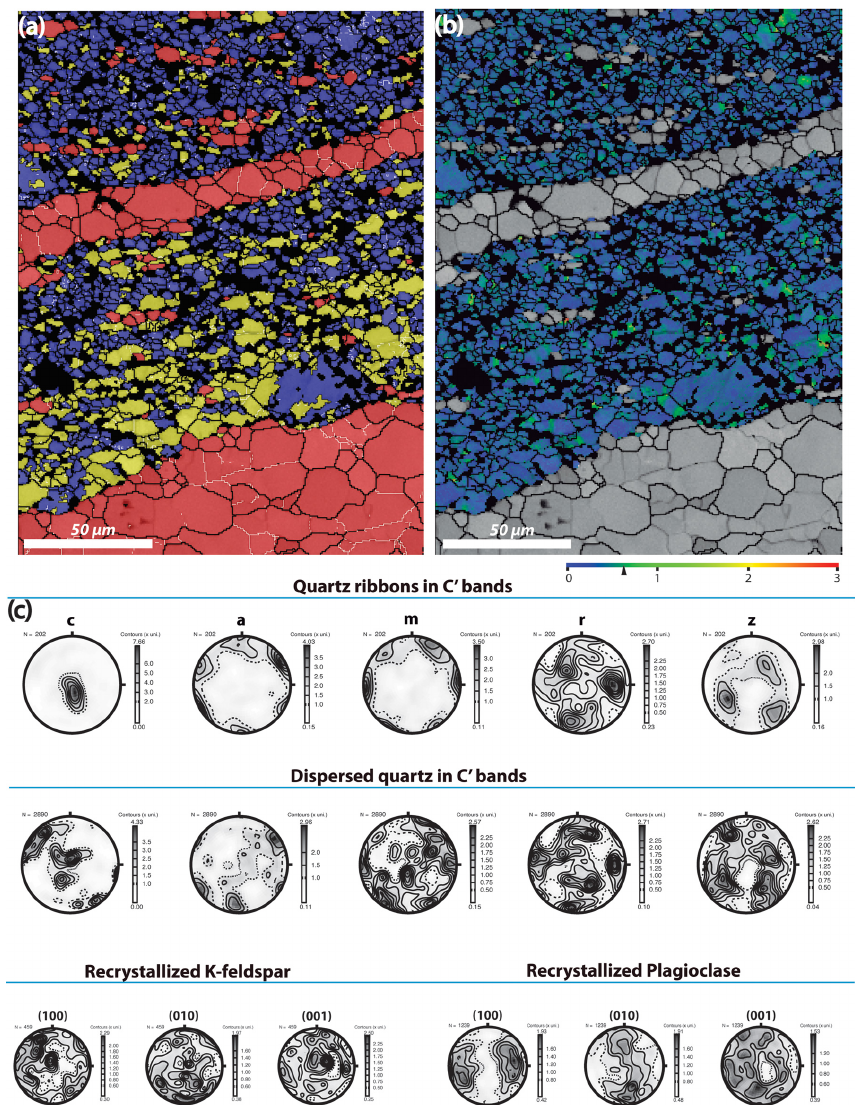
Figure 13. (a) EBSD phase map of a contact between quartz monomineralic veins (red in the bottom of the image) and a feldspathic C’ band; red is quartz, blue is plagioclase, yellow is K-feldspar. A thin monomineralic quartz ribbon embedded in the feldspathic matrix is also included in the map. (b) Local misorientation map of the fine-grained feldspathic matrix; colour bar as in Fig. 11. (c) Pole figures of the crystallographic orientation of K-feldspar, plagioclase and quartz (monophasic ribbon and scattered quartz in the matrix are plotted separately). See text for